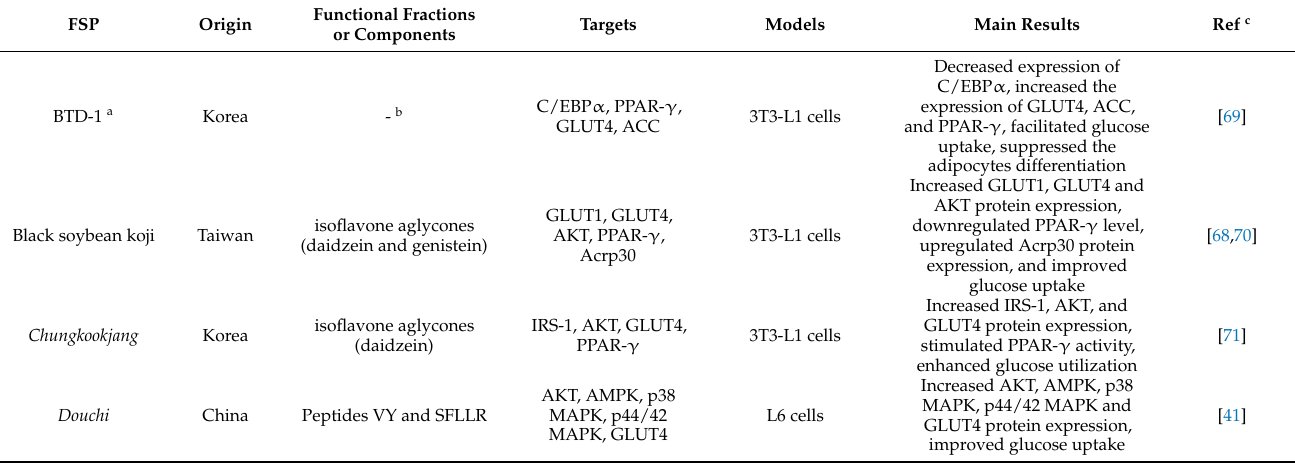
Table 2. Studies associated with hypoglycemia of FSP to prove GLUT4 expression and GLUT4